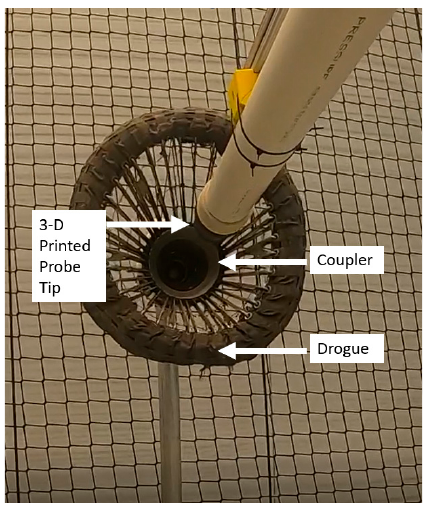
Figure 6. United States Naval Academy probe ‐ and ‐ drogue test equipment.